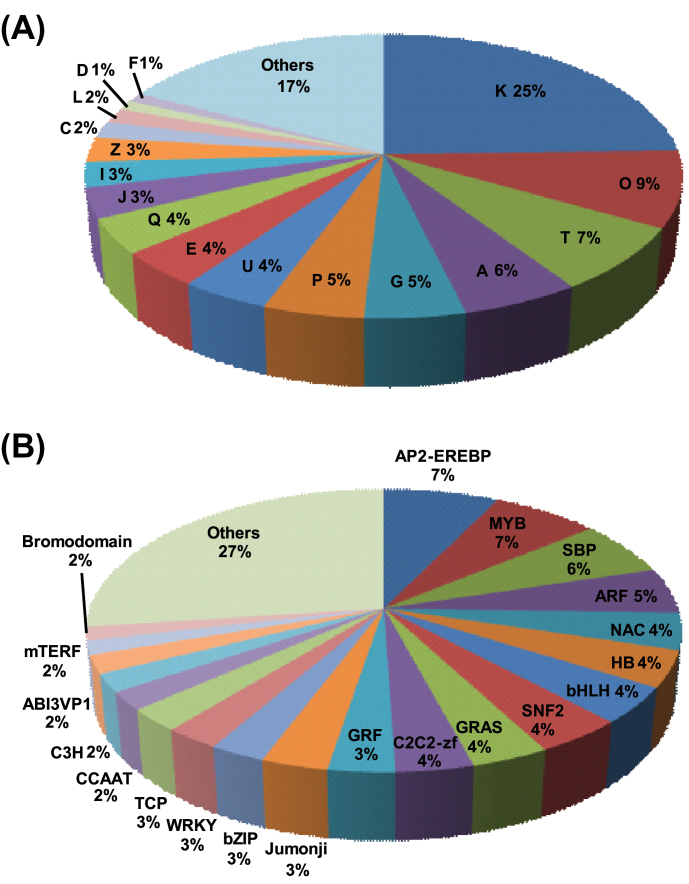
Functional annotation of predicted targets of chickpea miRNAs. (A) Pie chart showing distribution of different functional classes represented in the predicted targets. K, transcription; O, posttranslational modification, protein turnover, and chaperones; T, signal transduction mechanisms; A, RNA processing and modification; G, carbohydrate transport and metabolism; P, inorganic ion transport and metabolism; U, intracellular trafficking, secretion, and vesicular transport; E, amino acid transport and metabolism; Q, secondary metabolite biosynthesis, transport, and catabolism; J, translation, ribosomal structure, and biogenesis; I, lipid transport and metabolism; Z, cytoskeleton; C, energy production and conversion; L, replication, recombination, and repair; D, cell cycle control, cell division, and chromosome partitioning; F, nucleotide transport and metabolism. (B) Pie chart showing various transcription factor families represented in the predicted targets of chickpea miRNAs. This figure is available in colour at JXB online.